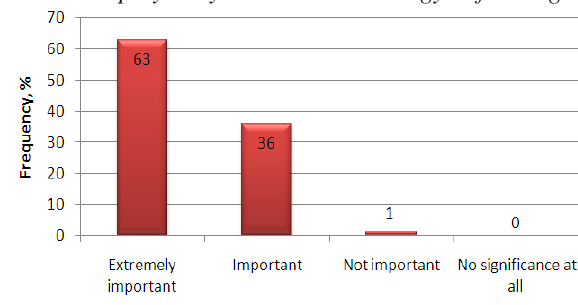
Fig. 17. Farmer perception of role played by technology in farming